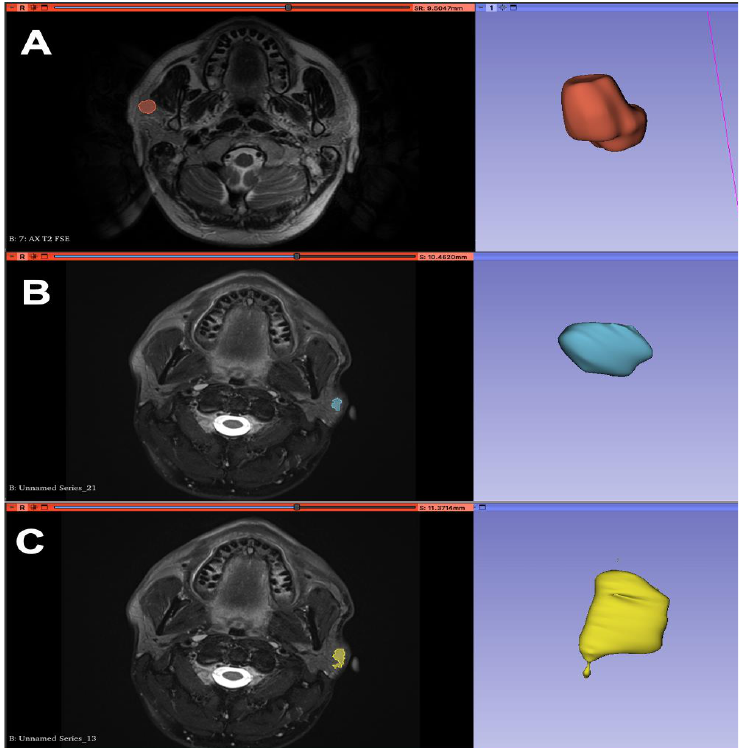
Figure 1. Segmentation of MRI images in axial T2 projection with 3D reconstruction of the ROI (region of interest) using 3D Slicer software: pleomorphic adenoma ( A ), Warthin tumor ( B ), ma- lignant neoplasm ( C ).